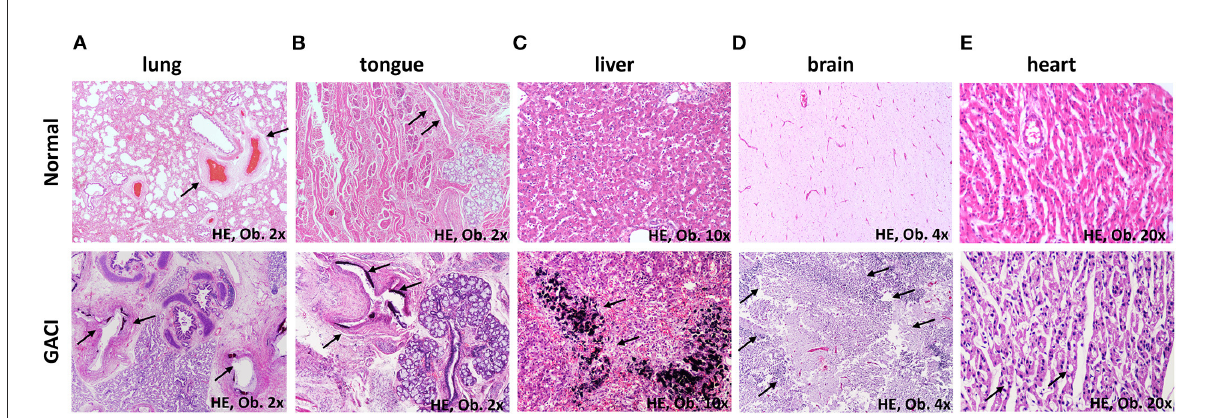
FIGURE1 Microscopic findings of the multisystemic GACI compared with normal structures (arrows): (A) Calcifications of the medium-sized arteries of the lung. (B) Intimal calcifications of the arteries of the tongue. (C) Calcifications of the hepatocytes. (D) Necrosis of the brain parenchyma. (E) Hydropic changes of the myocardial fibers.